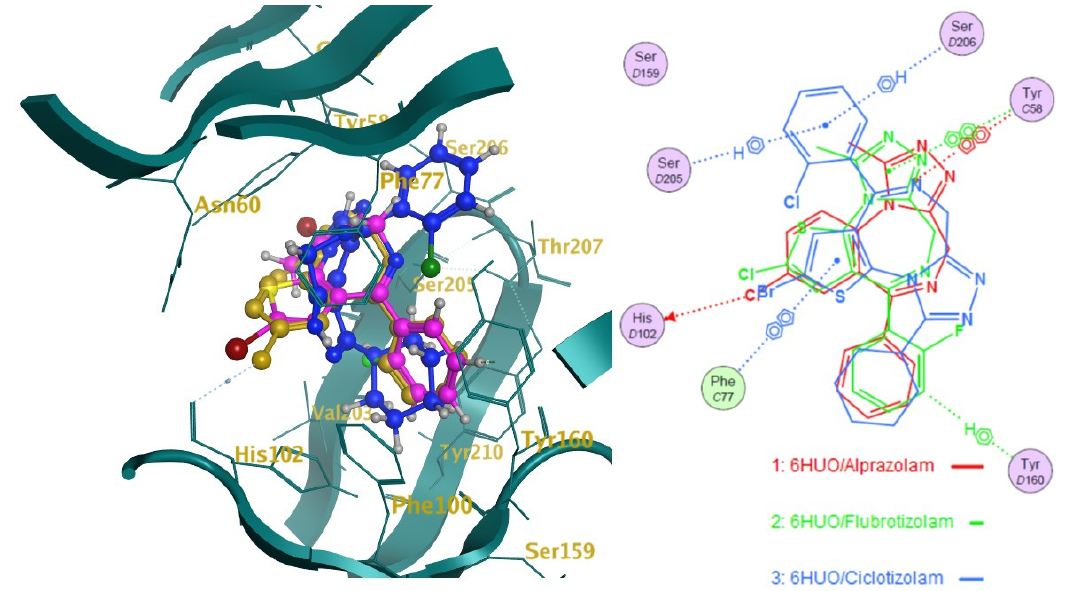
Figure 7. Docking studies on 6HUO [61] binding pocket. Notes: on the left side, the 3D representation of the molecules (Flubrotizolam, Ciclotizolam) docked on the co-crystallised ligand (alprazolam in gold). On the right side is the 2D representation of the ligands’ interactions with the residues of the binding pockets. The dotted lines indicate a hydrogen bond (donor or acceptor according to the direction of the arrow at the end of it) between the ligand and the pocket residues; the dotted lines showing the H and benzene symbol indicate an arene-hydrogen interaction, while the ones showing the two benzene symbolizes an arene-arene